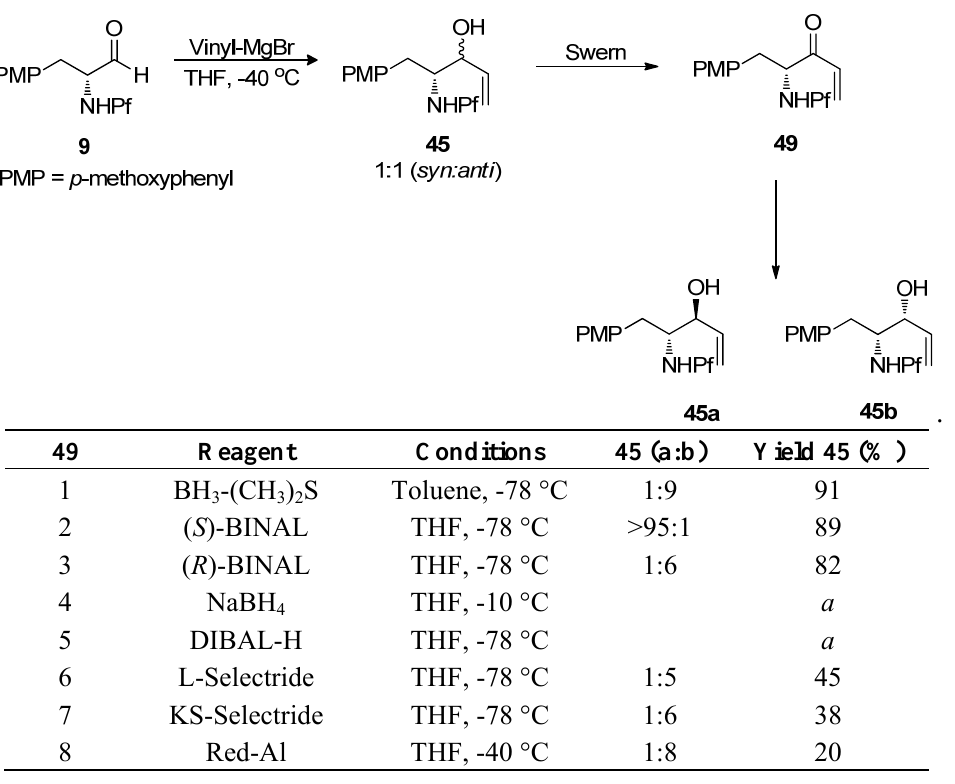
Table 7. Effect of the conditions and reagents in the stereoselectivity of the reduction.